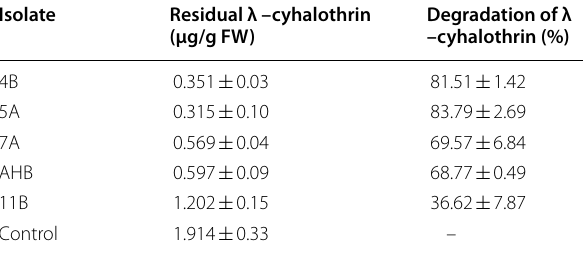
Table 4 Residual λ-cyhalothrin concentration and percentages of degradation in Vicia faba seedlings after one week of spraying Isolate Residual λ –cyhalothrin (µg/g